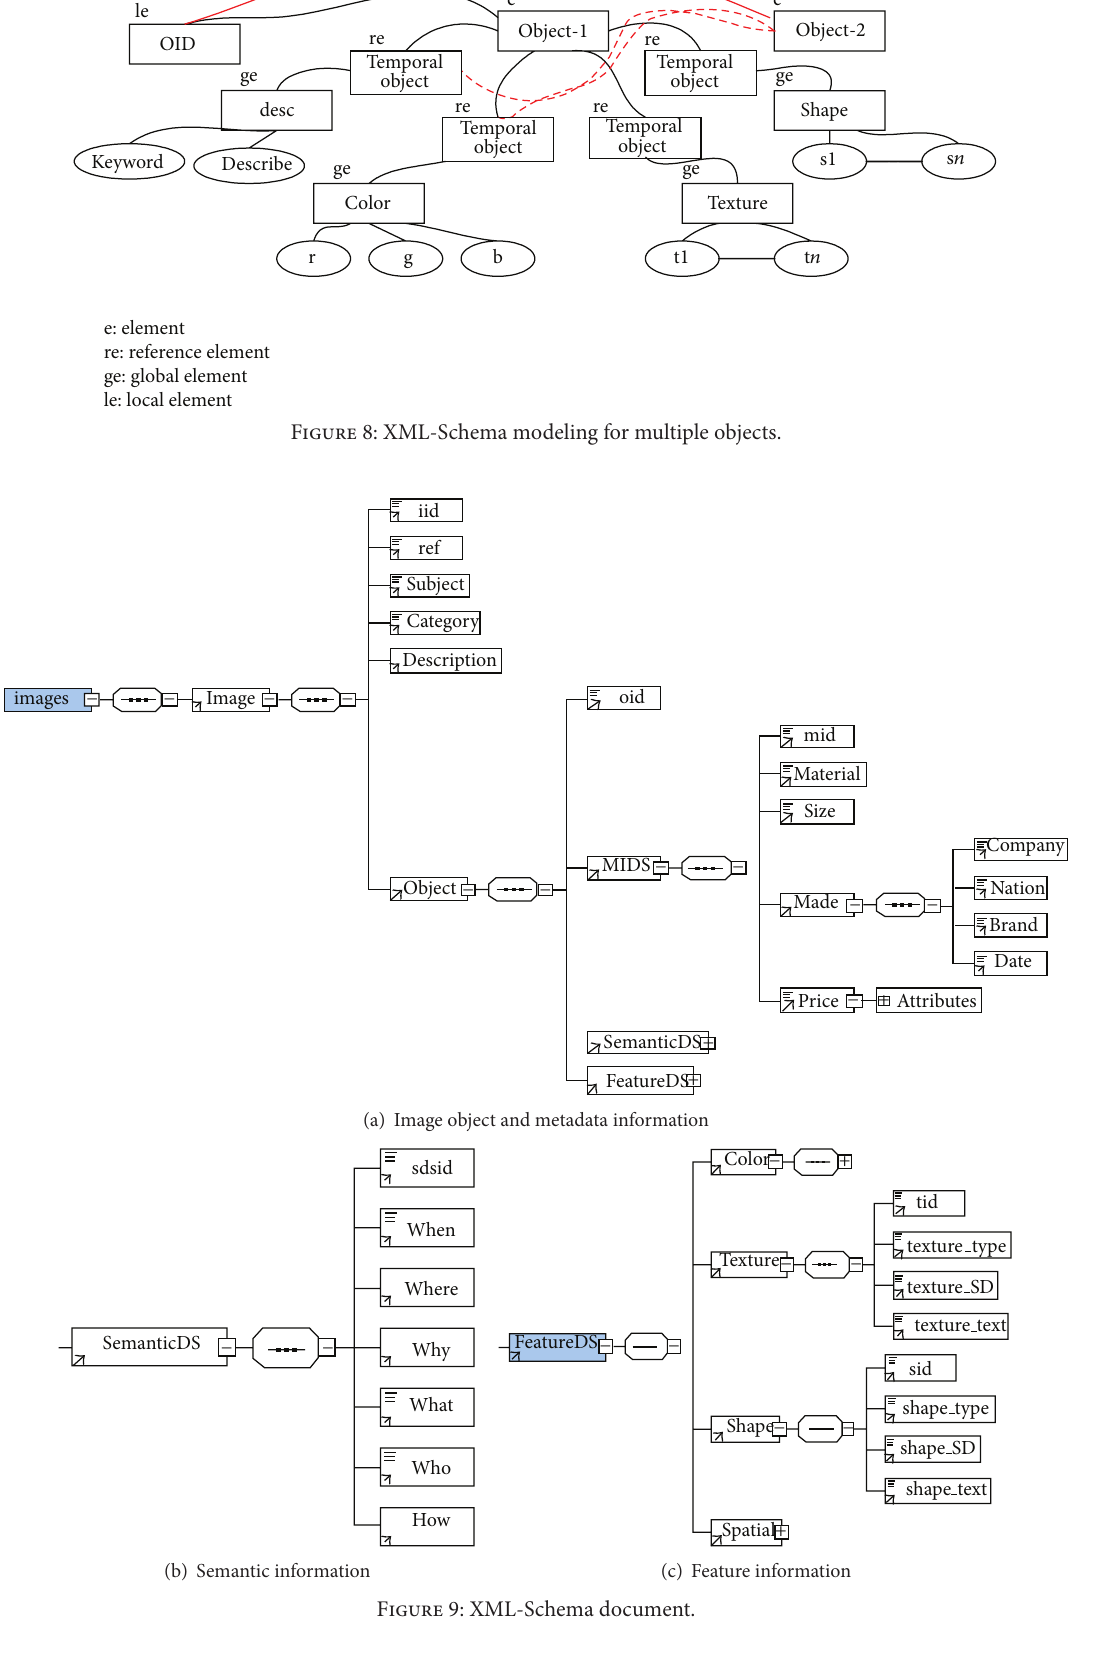
Figure 9: XML-Schema